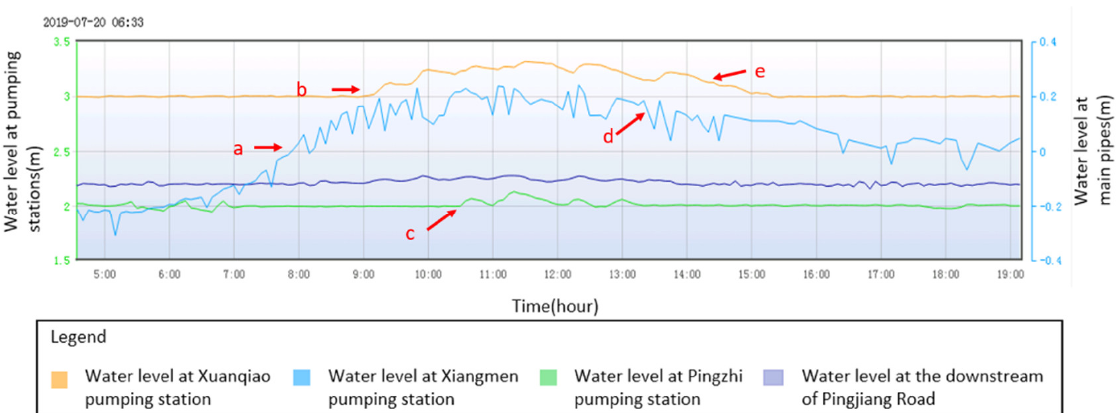
Figure 11. The effect of implementing the control model for typical two-stage three pumping sta-